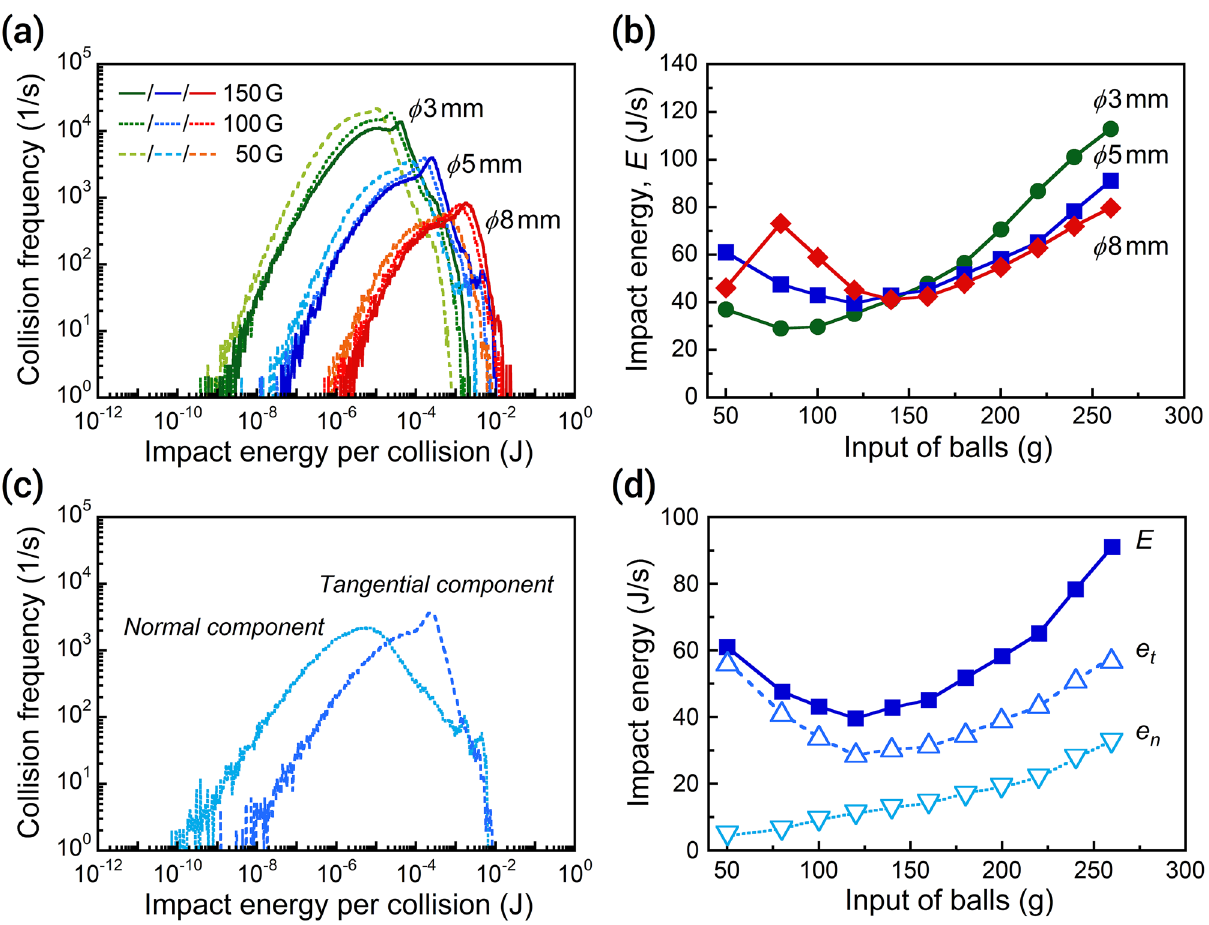
Figure 2. Impact energies between balls calculated for various planetary ball milling conditions in water. ( a ) Distributions of impact energy per collision at the ball input of 100 g. ( b ) Relationship between the input of balls ( 3–8 mm) and the total impact energy at 150 G. ( c ) Distributions of impact energies in the normal and tangential directions at 150 G with 5 mm balls (100 g). ( d ) Relationship between the input of ϕ the impact energies of each component at 150 ϕ